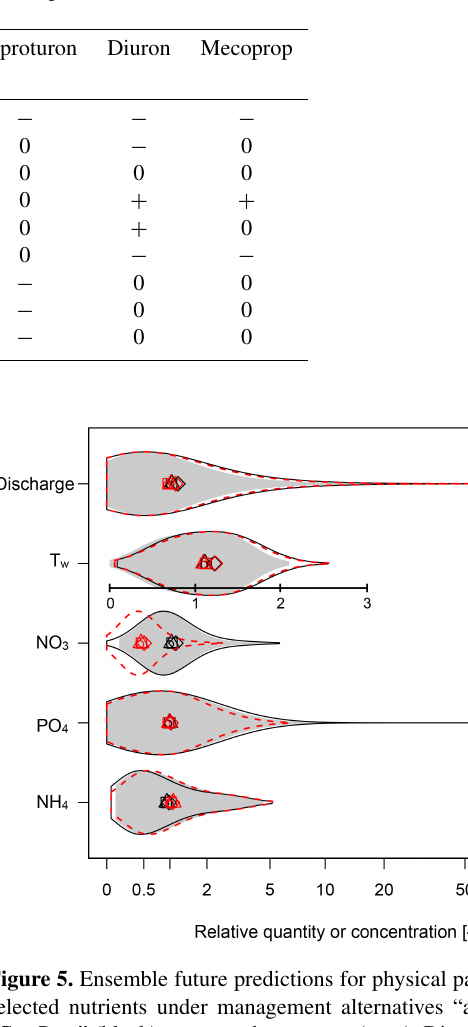
Table 6. Signs of change for future physical parameters and selected representative micropollutant concentrations considering management only [assuming present climate + status quo]. The full version is shown in the Supplement (Sect. S5). Notation is the same as for Table 4. + : general increase, − : general decrease, ± : quantile-specific response, 0: no change.